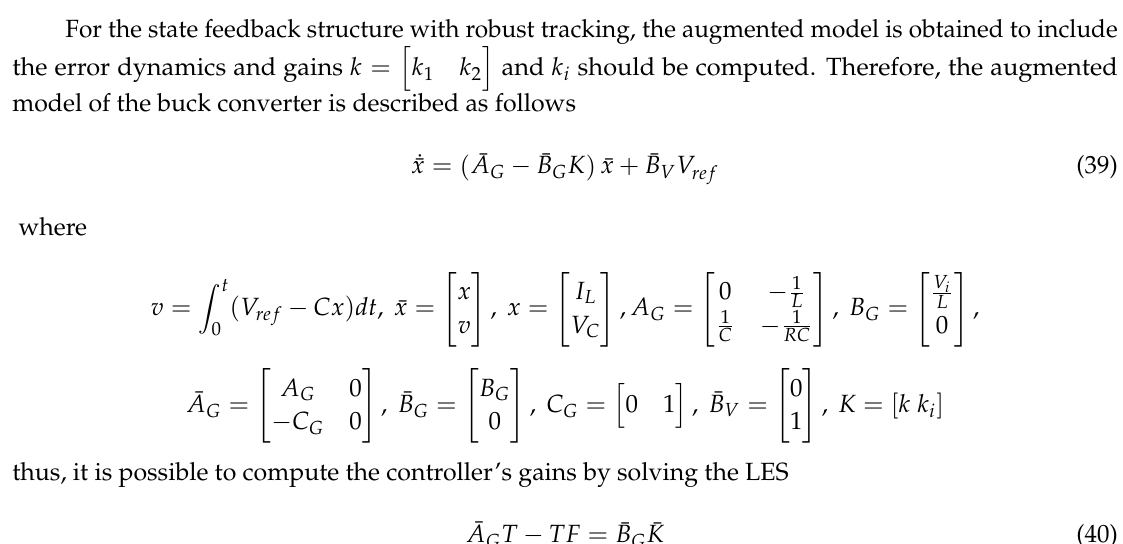
Figure 9. Desired performance region in s